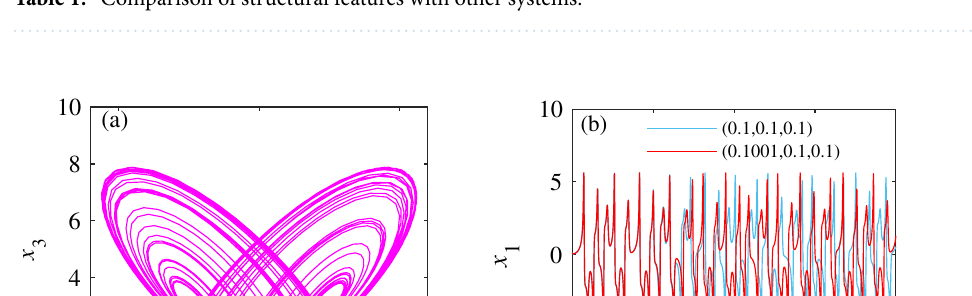
Figure 1. Attractor diagram and time series diagram. ( a ) Parameter a plane when the initial value is (0.1, 0.1, 0.1). ( b ) Time series comparison diagram with initial values of (0.1, 0.1, 0.1) and (0.1001, 0.1,